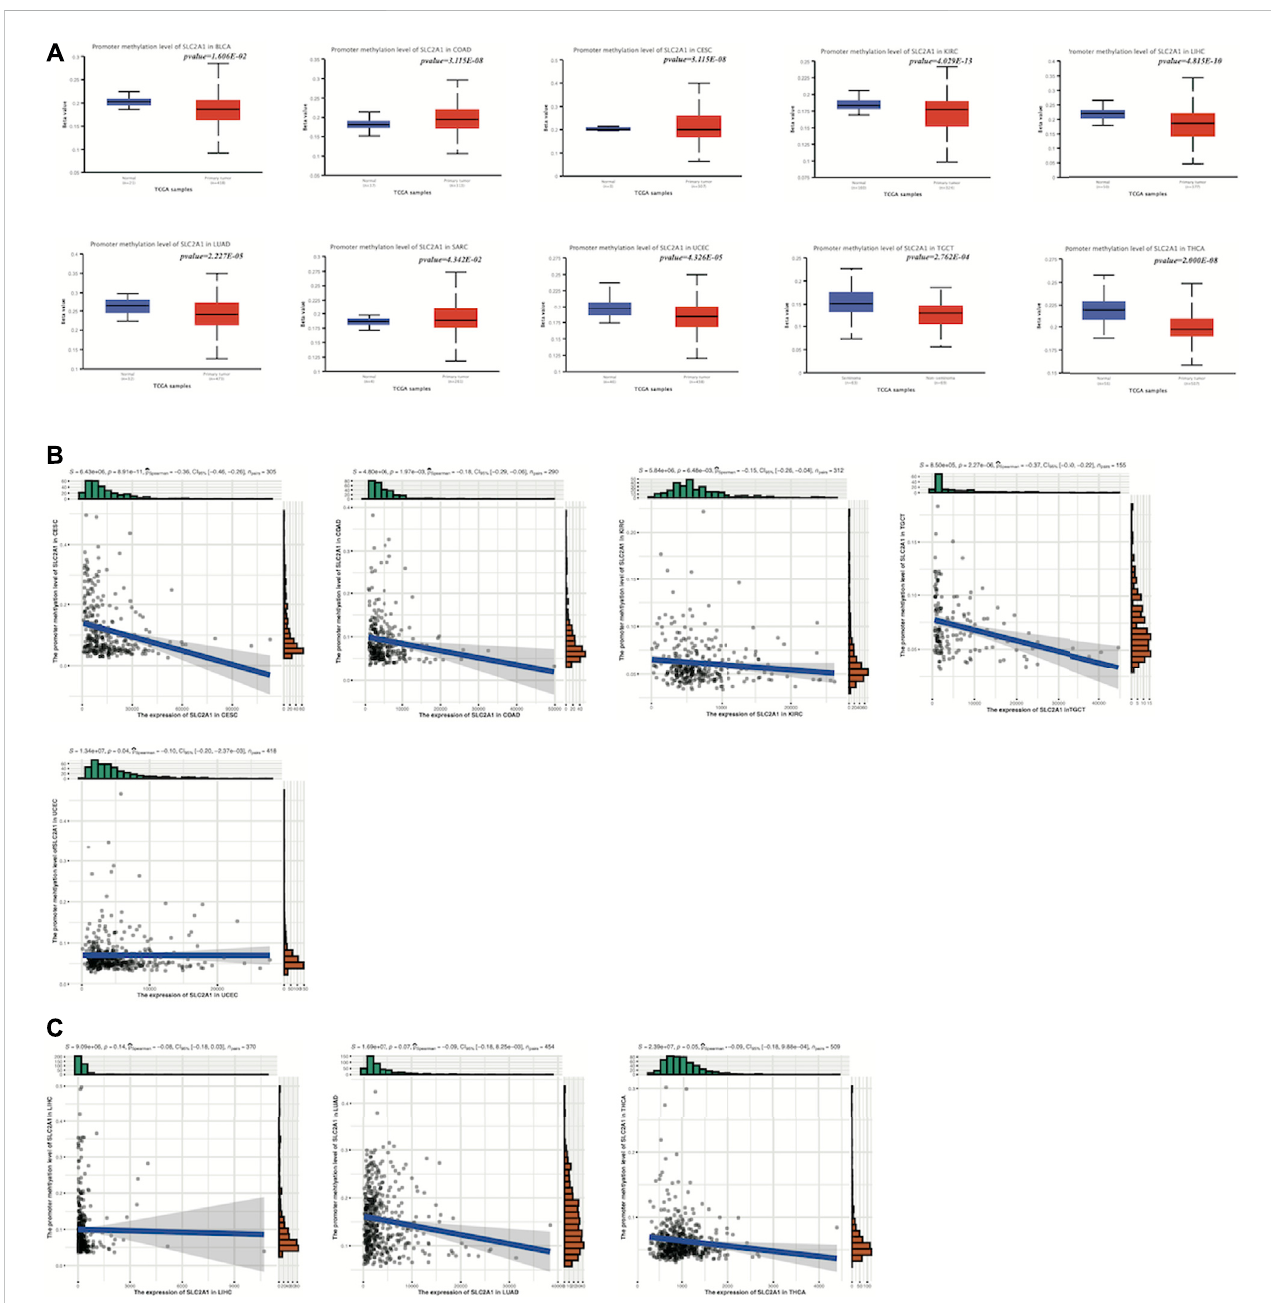
FIGURE 2 SLC2A1 promoter methylation was aberrantly expressed in multiple cancers and correlated with SLC2A1 transcriptome expression levels (A) SLC2A1 promoter methylation levels were aberrantly expressed in BLCA, COAD, CESC, KIRC, LIHC, LUAD, SARC, UCEC, TGCT and THCA (B) The transcriptome expression levels of SLC2A1 were signi fi cantly correlated with the promoter methylation levels of SLC2A1 in CESC, COAD, LUAD, TGCT and THCA (C) The transcriptome expression levels of SLC2A1 were not correlated with the promoter methylation levels of SLC2A1 in UCEC, LIHC and